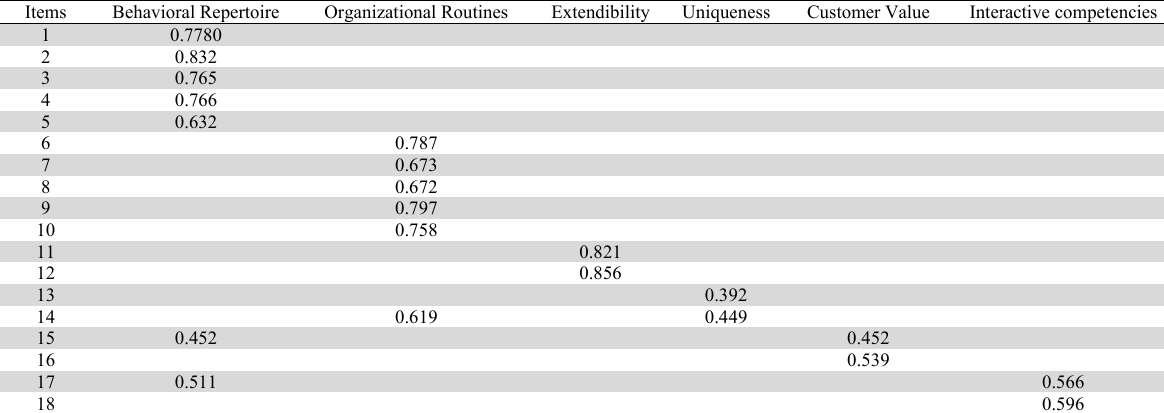
Distinction between the three constructs of the study